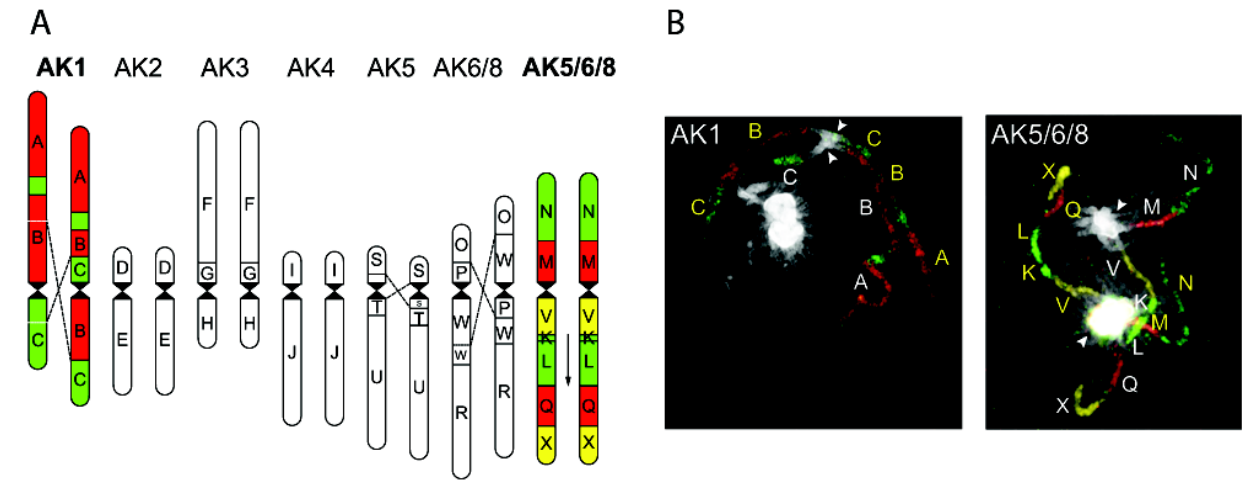
Figure 4. Idiogram and corresponding FISH to pachytene spreads using Arabidopsis thaliana genomic BACs to the autotetraploid Goldbachia laevigata (2 n = 4 x = 28) (Brassicaceae; Calepineae). (A) Chromosomes are annotated corresponding to the ancestral karyotype (AK) for crucifers [31,64]. Lines between chromosomes indicate the boundaries of pericentric inversions distinguishing homologous chromosomes, an arrow indicates an inversion relative to the crucifer AK. (B) FISH to two pachytene bivalents of AK1 and AK5/6/8 chromosomes hybridised with pooled BACs are shown pseudocoloured as red, yellow and green. Yellow and white letters distinguish each